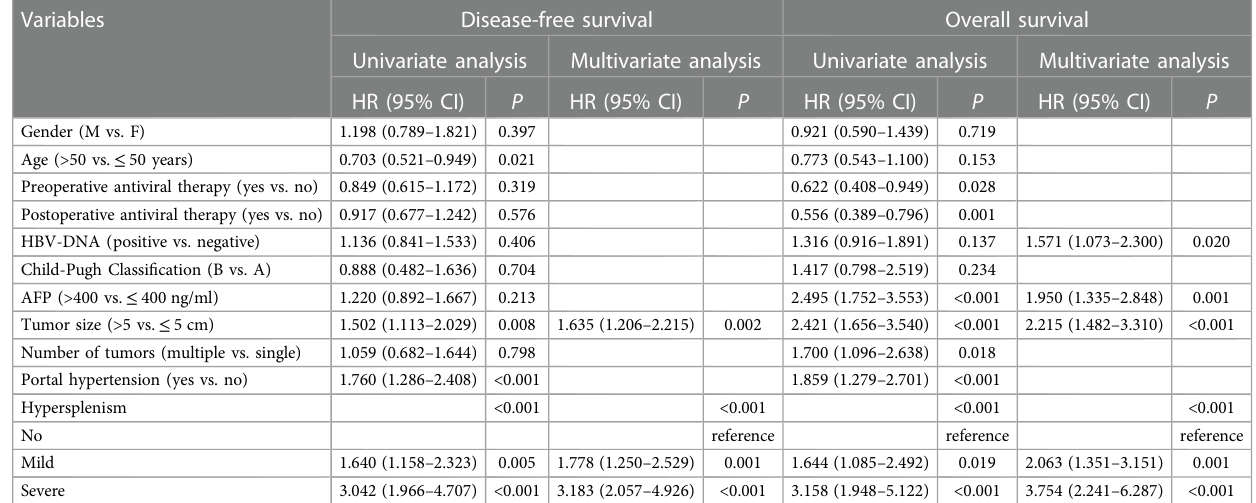
TABLE 4 Univariate and multivariate analyses of prognostic factors for disease-free survival and overall survival. Variables Disease-free survival Overall survival Univariate analysis Multivariate analysis Univariate analysis Multivariate